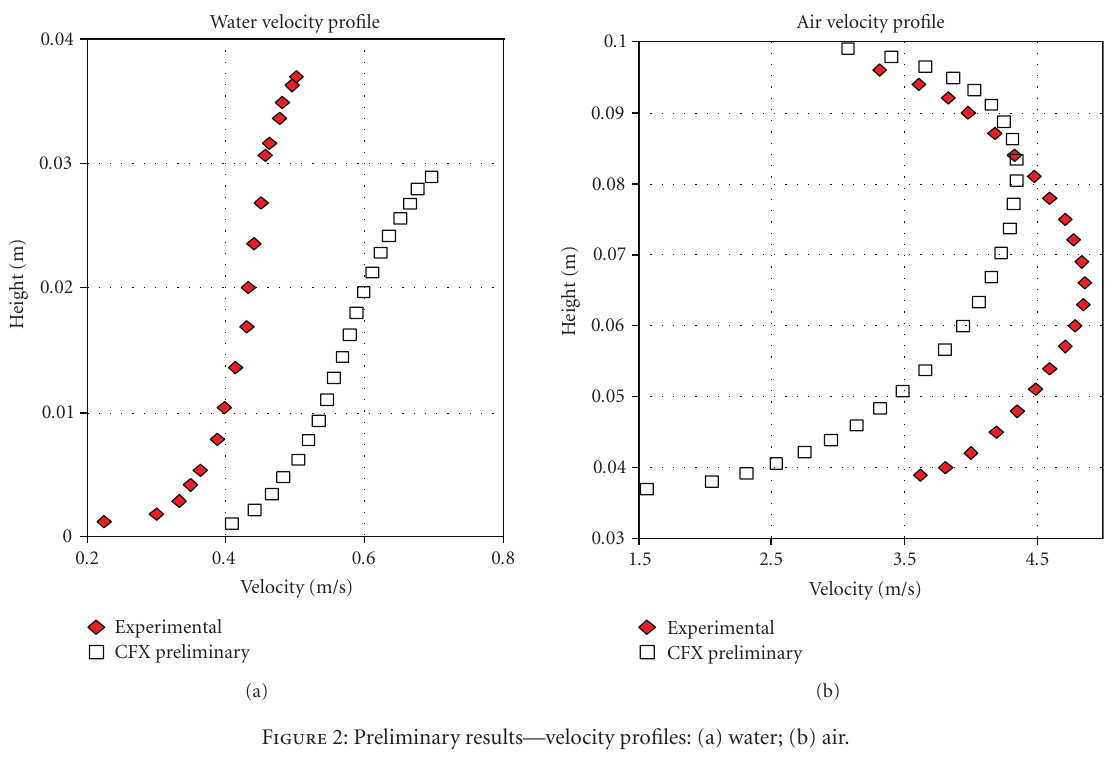
Figure 2: Preliminary results—velocity profiles: (a) water; (b) air.